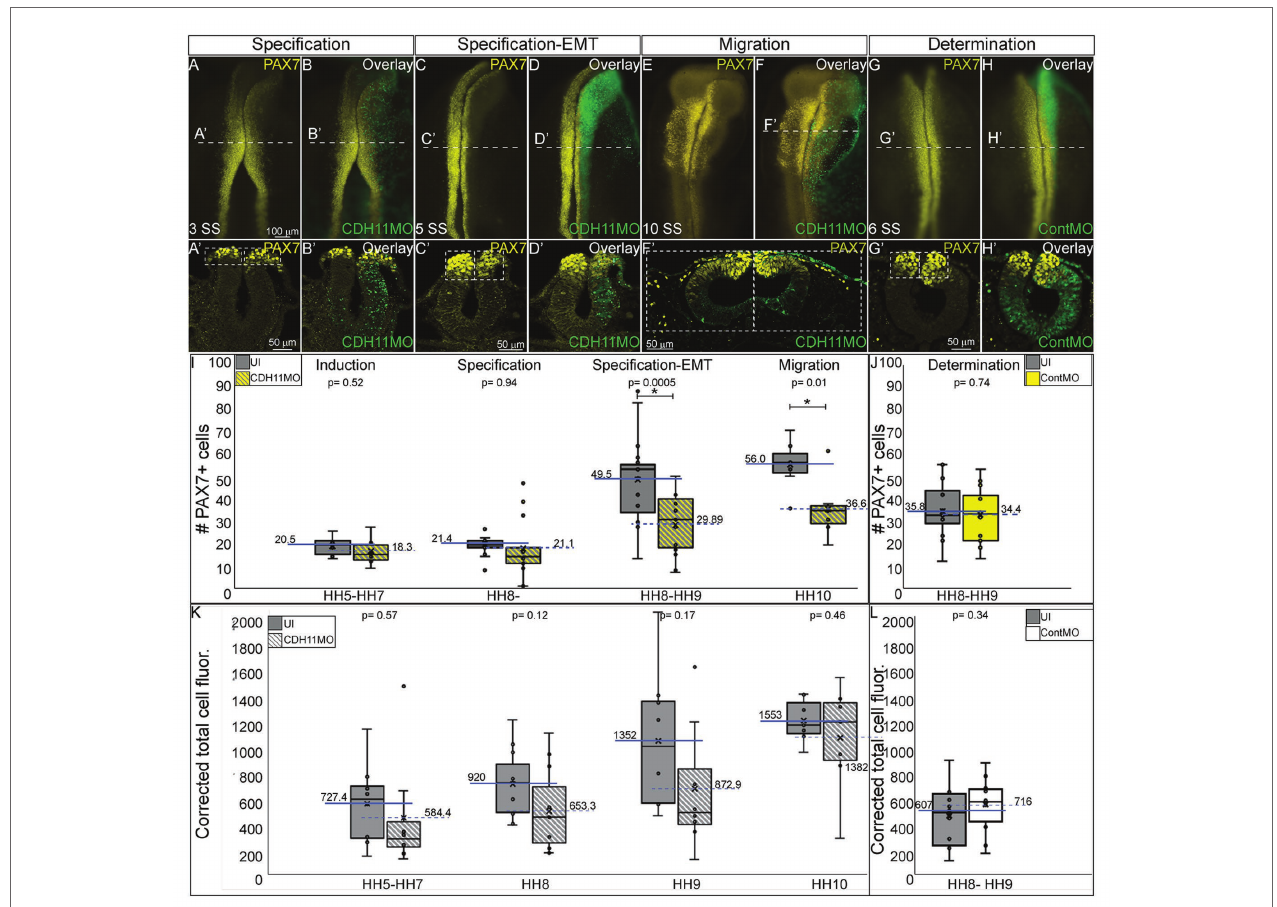
FIGURE 2 | CDH11 is required for NC cell population specification. Embryos were injected at HH4 and collected at multiple stages to analyze NC progenitor marker, PAX7. (A-F’) IHC for PAX7 on embryos injected with CDH11MO and collected between 3 SS and 10 SS. (G–H’) IHC for Pax7 in embryo injected with ContMO and collected at 6 SS. (I,J) Actual PAX7+ cell counts of uninjected and morpholino-injected sides. (K) Corrected total cell fluorescence of PAX7 expression in section images injected with either CDH11MO or ContMO. (A) Whole mount IHC for PAX7 in HH8- (3 SS) embryo with (B) overlay with CDH11MO (green). (A’,B’) Transverse section of (A,B) with PAX7-positive NC cells circled. Mean number of cells at HH8- is 21.43 on uninjected and 21.14 on CDH11MO-injected side, p = 0.94, n = 14. (C) Whole mount IHC for PAX7 in HH8 embryo with (C) overlay with CDH11MO (green). (C’,D’) Transverse section of (C,D) with PAX7-positive NC cells boxed. Mean number of cells at HH8 is 49.53 on uninjected and 29.89 on CDH11MO-injected side, p = 0.0005, n = 19. (E) Whole mount IHC for PAX7 in HH10 embryo with (F) overlay with CDH11MO (green). (F’) Transverse section of (F) with PAX7-positive NC cells. Mean number of cells at HH10 is 56.00 on uninjected and 36.57 on CDH11MO-injected side, p = 0.01, n = 7. (G) Whole mount IHC for PAX7 in HH8 embryo with (H) overlay with ContMO (green). (G’,H’) Transverse sections of (G,H) with PAX7-positive NC cells circled. Mean number of cells on uninjected side is 35.8 and on ContMO-injected side is 34.4, p = 0.74, n = 14. Dashed boxes were drawn around NC cell population from uninjected side and are mirrored on injected sides to demonstrate changes in the NC cell population density. At 5 SS the NC cell population is less dense in the CDH11MO-side compared to uninjected when compared to 3 SS and ContMO-injected embryos. (K,L) Fluorescence intensity calculated using NIH ImageJ (see methods) from HH5 ( n = 8, p = 0.57), HH8 ( N = 11, p = 0.11), HH9 ( n = 8, p = 0.17), HH10 ( n = 7, p = 0.46), and ContMO HH8–9 ( n = 12, p = 0.34). Scale bars are as marked (100 μ m for whole mount and 50 μ m for sections). Anterior to top in all whole mount images, dorsal to top in all sections. Loss of CDH11 reduces the PAX7-positive NC cell population after induction ( I , HH5-3SS) and at a point between specification and determination (5